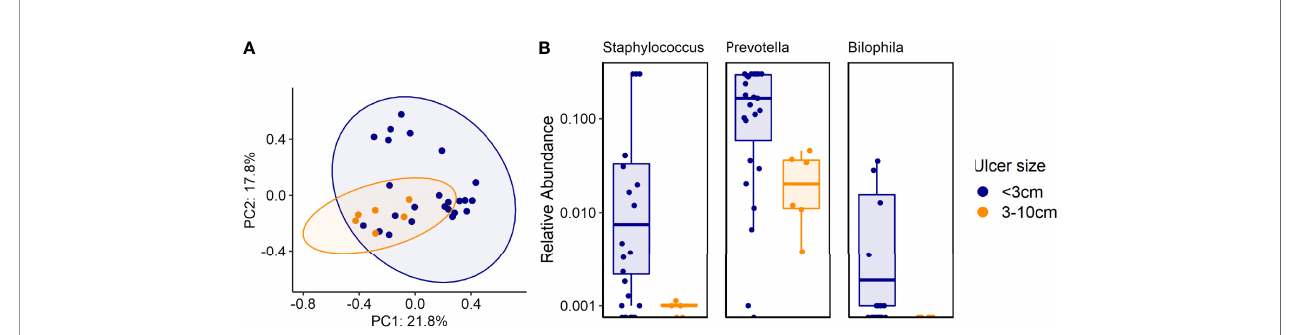
FIGURE 5 | (A, B) . Associations between certain genera and species and ulcer size. (A) Beta diversity (Bray-Curtis dissimilarity index) of samples from patients with different ulcer sizes: PCoA plot of taxonomic features shows the clustering of samples according to ulcer sizes. Ellipsoids represent a 95% con fi dence interval surrounding each group. p<0.01 (PERMANOVA). (B) 16S rRNA results analysis: Shown are genera that were more common in ulcers smaller than 3cm, compared with ulcers 3-10cm,